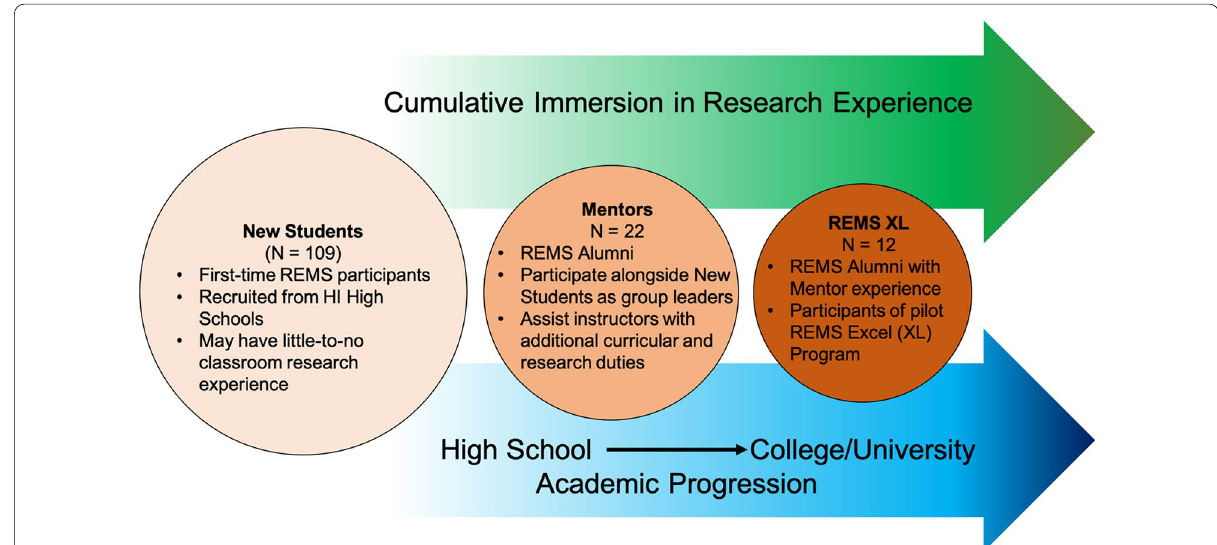
Fig. 3 Definitions of Program Student Groups. Mentors were recruited from the New Student group, and REMS XL students were recruited from the Mentor